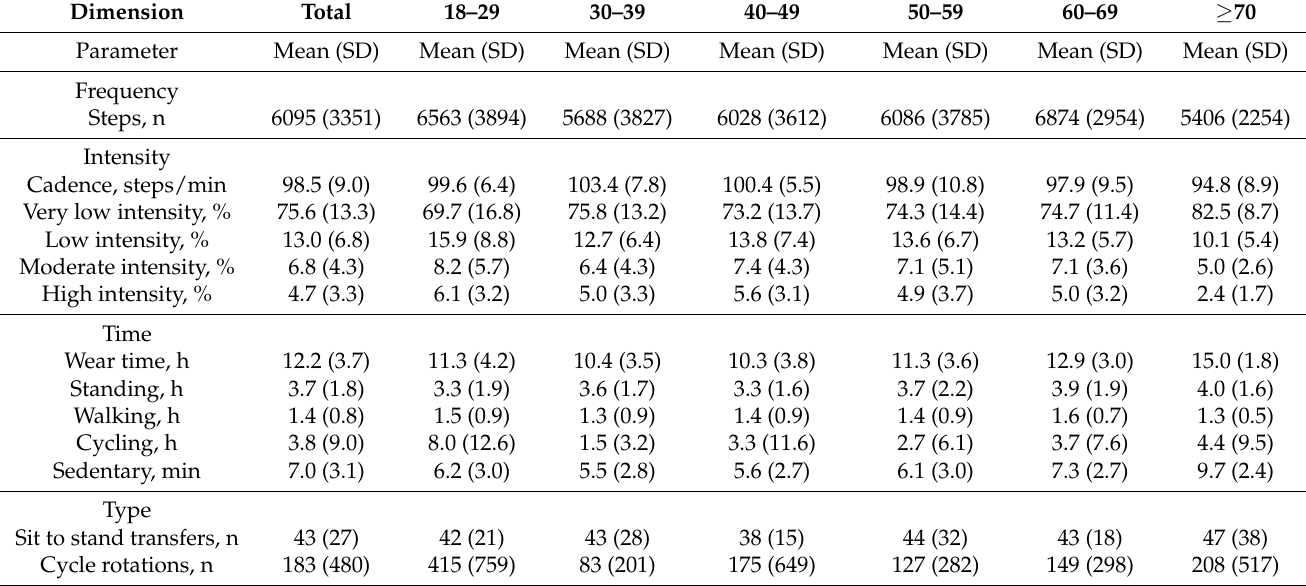
Table 2. Daily Physical Activity According to Age